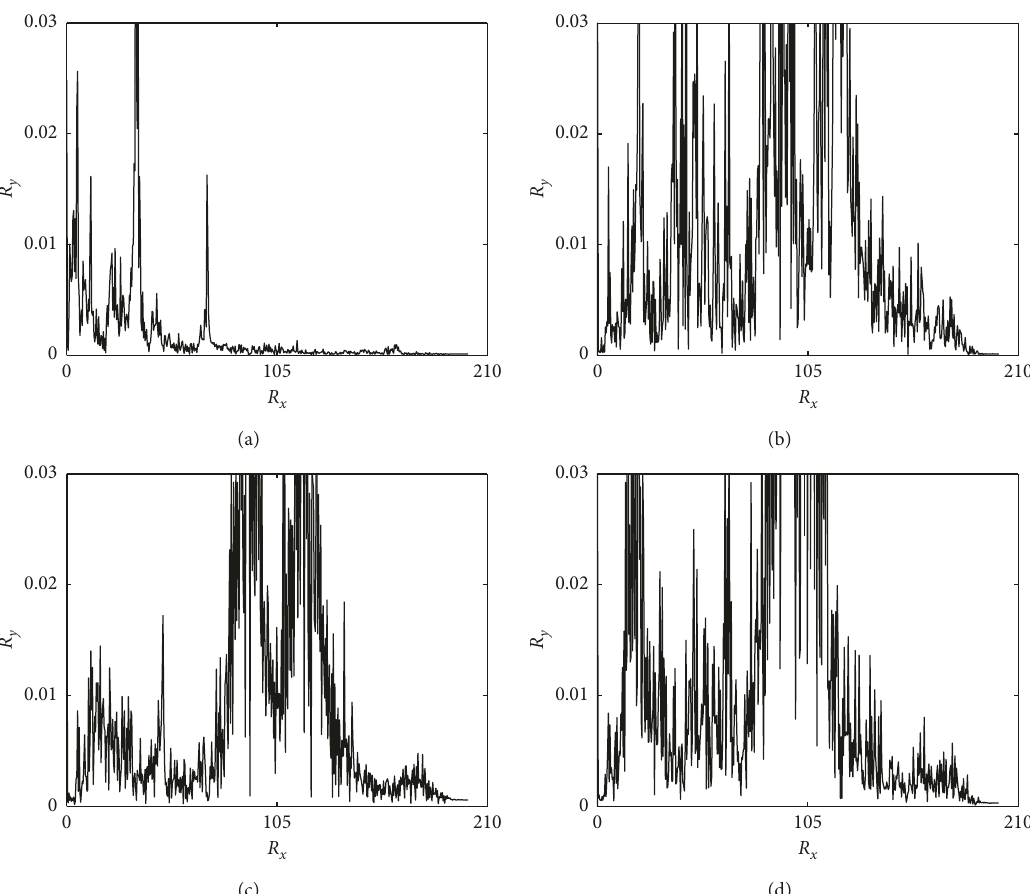
Figure 13: The adjusted spectrum images of D1 with the optimized CF: (a) normal; (b) 0.007 in; (c) 0.014 in; (d) 0.021